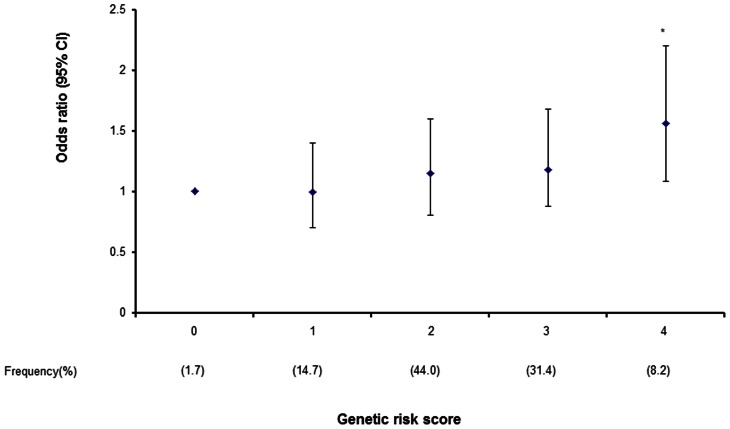
Based on results of a meta-analysis of risk association of type 2 diabetes (T2D) in 9,901 Asian subjects with de novo genotyping, each risk allele of rs1583645 (CPE) and rs6583813 (IDE) was given a genetic risk scores (GRS) of 1 under additive models.Increasing GRS was associated with increasing trend of risk for T2D (P
meta  = 0.01; Q-statistic P<0.05) with the highest GRS of 4 conferring an odds ratios of 1.56 compared to the lowest GRS of 0 (*P = 0.01).